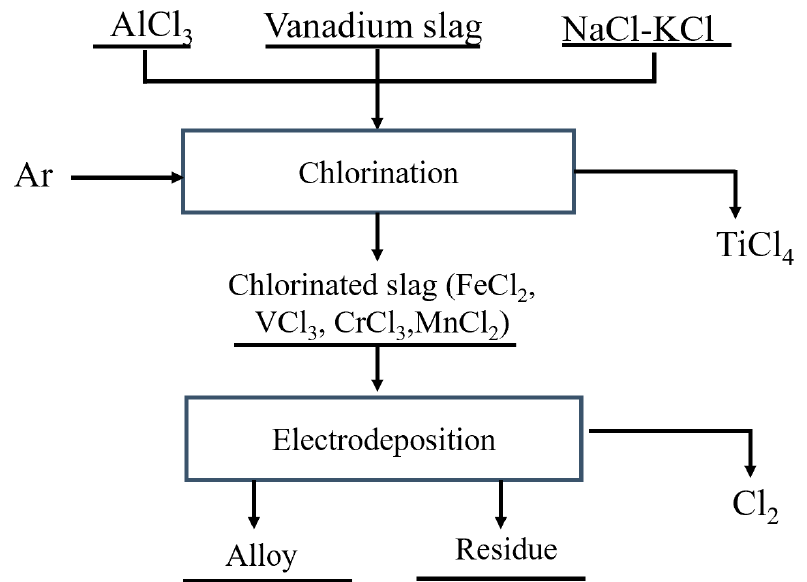
Figure 7. Flow chart of extracting vanadium from vanadium slag by AlCl 3 chlorination.